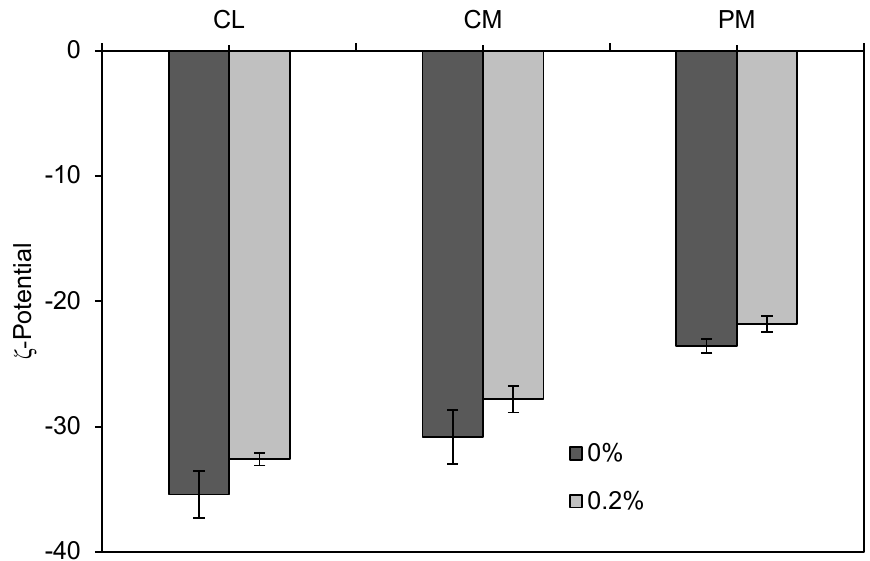
Figure 1. ζ - potential values of chia O/W emulsions at pH 6.5.